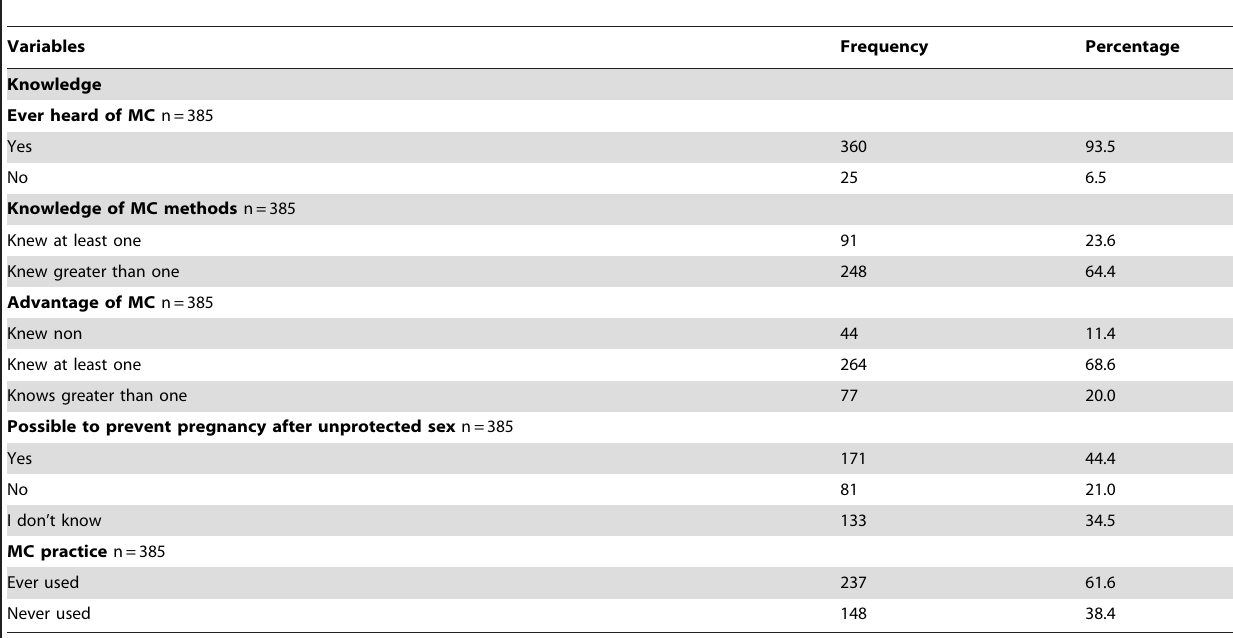
Table 3. Knowledge and Practice of Modern Contraceptives among Pregnant Married Women in Hossana Town, SNNP, April 2011.